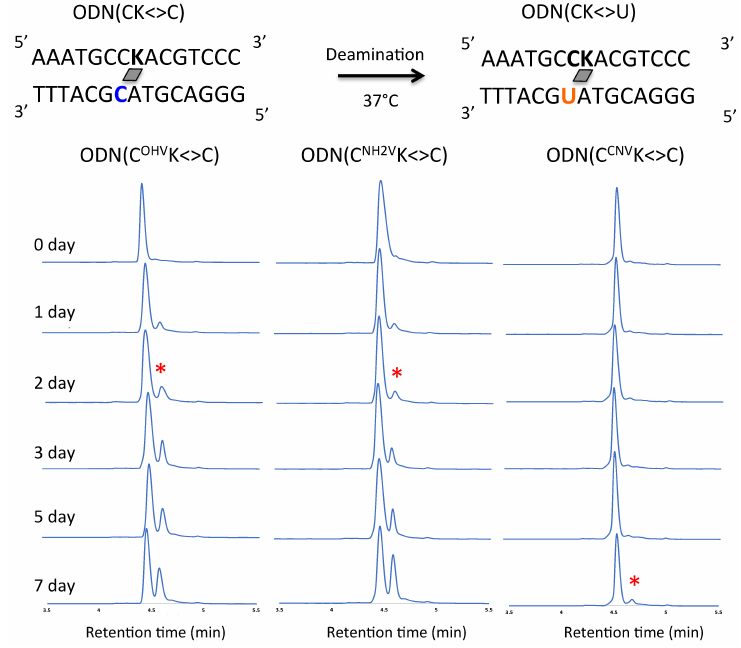
Figure 5. UPLC analysis of the deamination reaction of the photo-cross-linked duplex consisting of ODN(CK) and cODN(C). [ODN(CK<>C)] = 5 µ M in 50 mM Na-cacodylate buffer (pH 7.4) containing 100 mM NaCl. incubated at 37 ◦ C, photo splitting was performed with transilluminator (312 nm) at 37 ◦ C. Peak marked with asterisk ( * ) indicate the newly formed ODN(U) with asterisk indicate the newly formed